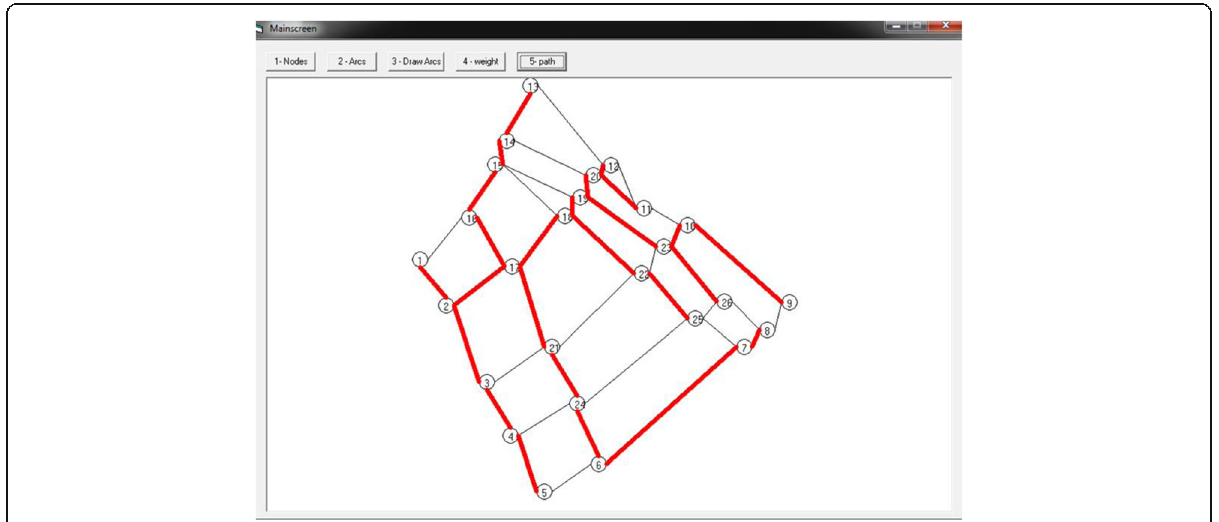
Fig. 22 The Results Derived from Implementing the Model of Buildings Vulnerability Index on the Sample Data using Software